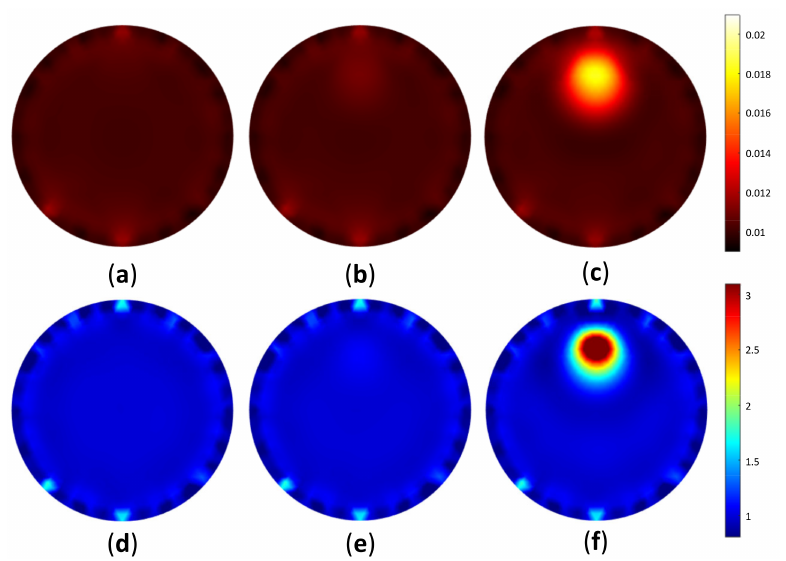
Figure 9. Reconstructed image of case A1, as shown in Table 1, representing ( a ) µ a homogeneous,